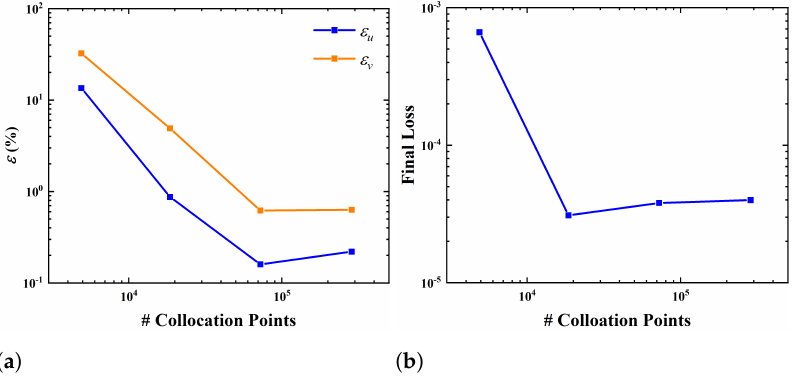
Figure 13. Influences of the number of collocation points on ( a ) velocity error and ( b ) final loss.